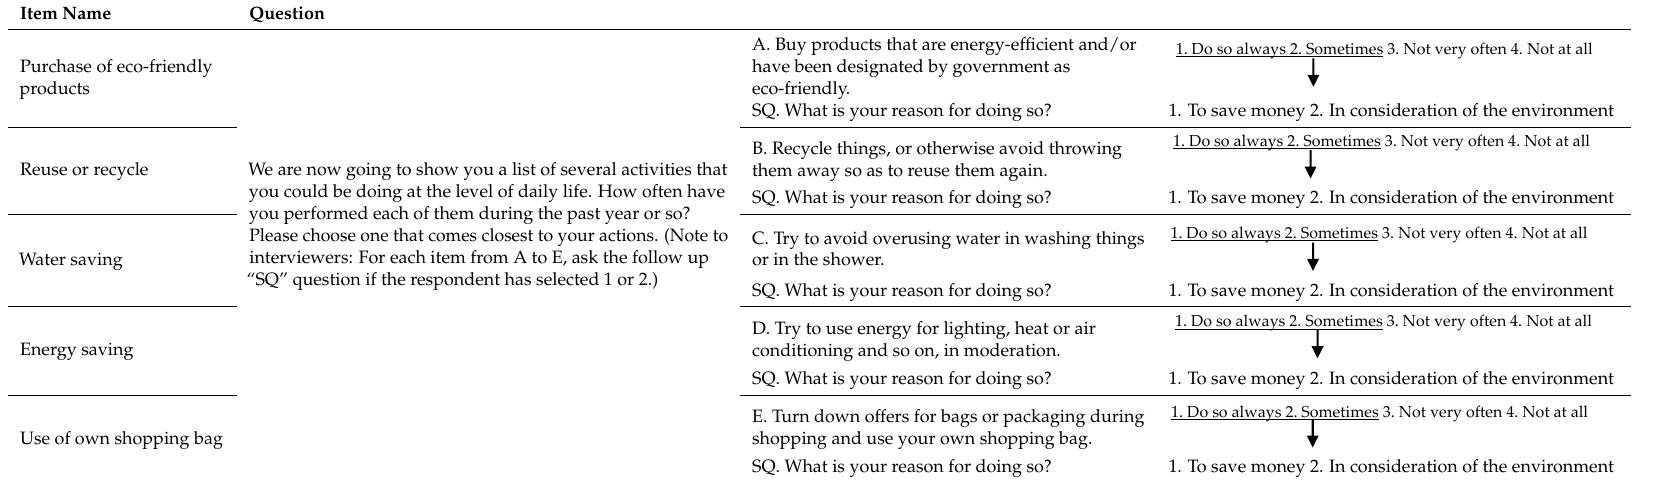
Table 1. Question items regarding environmentally significant behaviours and motivations.